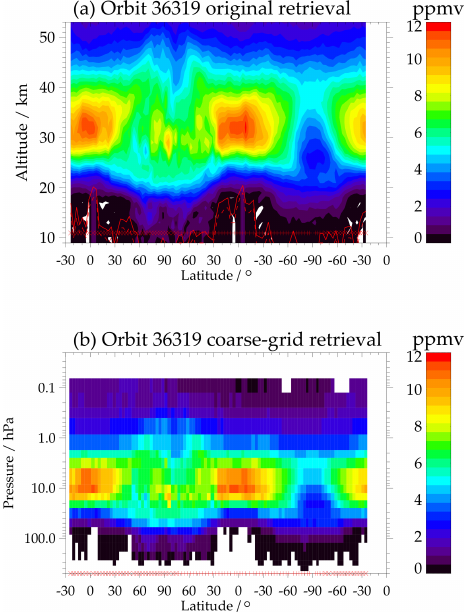
Figure 9. Ozone distribution for orbit 36319 on 20 February 2009 in the standard representation on the fine retrieval grid, where the vertical resolution is state- and thus time-dependent (a) and on the coarse retrieval grid (b) , where the vertical resolution is defined by the vertical